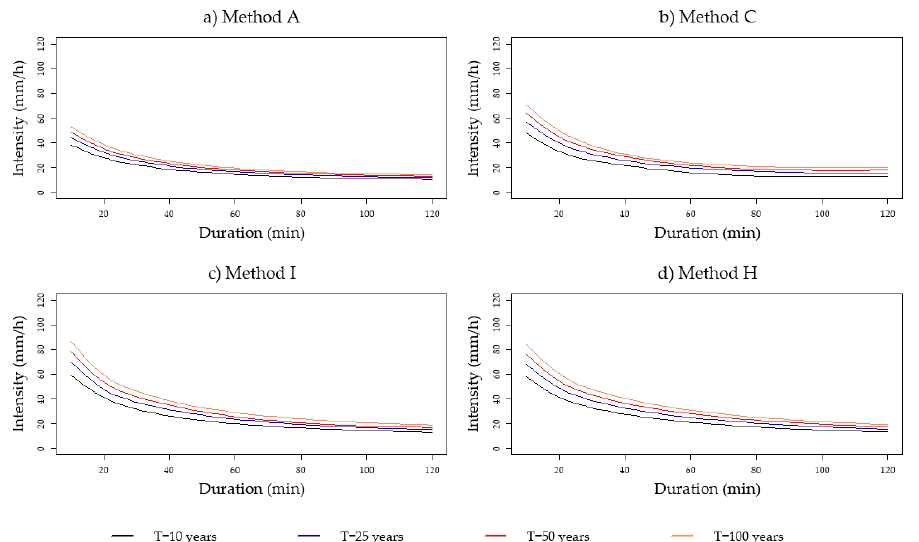
Figure 6. Established comparison of the IDF relationship estimated through different methods for station 2072 for different return periods. Figure 6a shows the IDF curves from method (A), estimated from pluviograph records using Gumbel (Equation (1)). Figure 6b shows the IDF curves from method (C) estimated from isohyetal map of the SCT. Figure 6c shows the IDF curves from method (H) estimated from the average of IDF developed by methods A, B, C, D, E, F, and G, and Figure 6d shows the IDF curves from method (I) estimated from Chen equation using the ( R ) ratio proposed (Equation (8)).